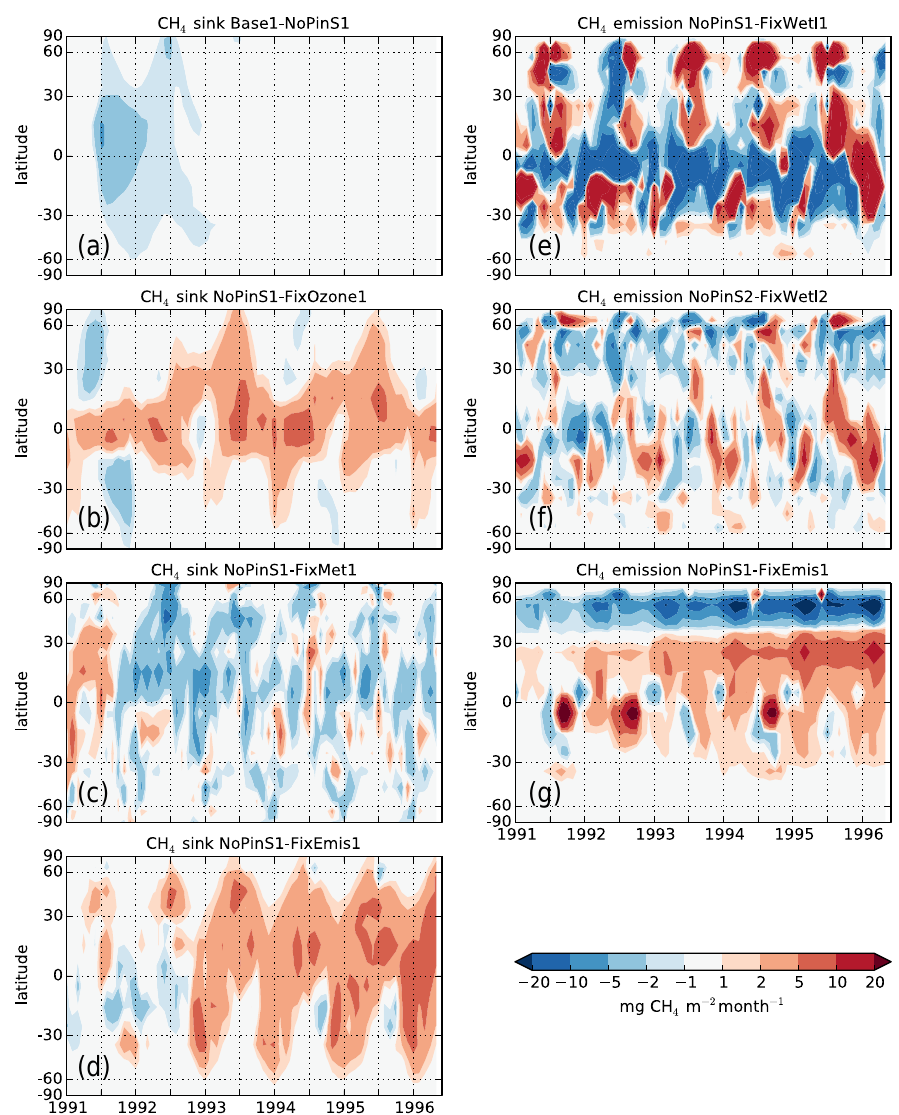
Figure 2. Zonal mean differences in the CH 4 budget terms caused by the different drivers of CH 4 variability, vertically integrated over the troposphere. Changes in the CH 4 sink by the reaction with OH are shown for the effects of (a) stratospheric sulfur, (b) stratospheric ozone, (c) meteorology and (d) emissions of CO, NO X and NMVOC. CH 4 emission changes are shown for wetlands from (e) ORCHIDEE and (f) LPJ, and (g) for biomass burning and anthropogenic sectors. The years on the x axis in this and later figures refer to the start of the year.